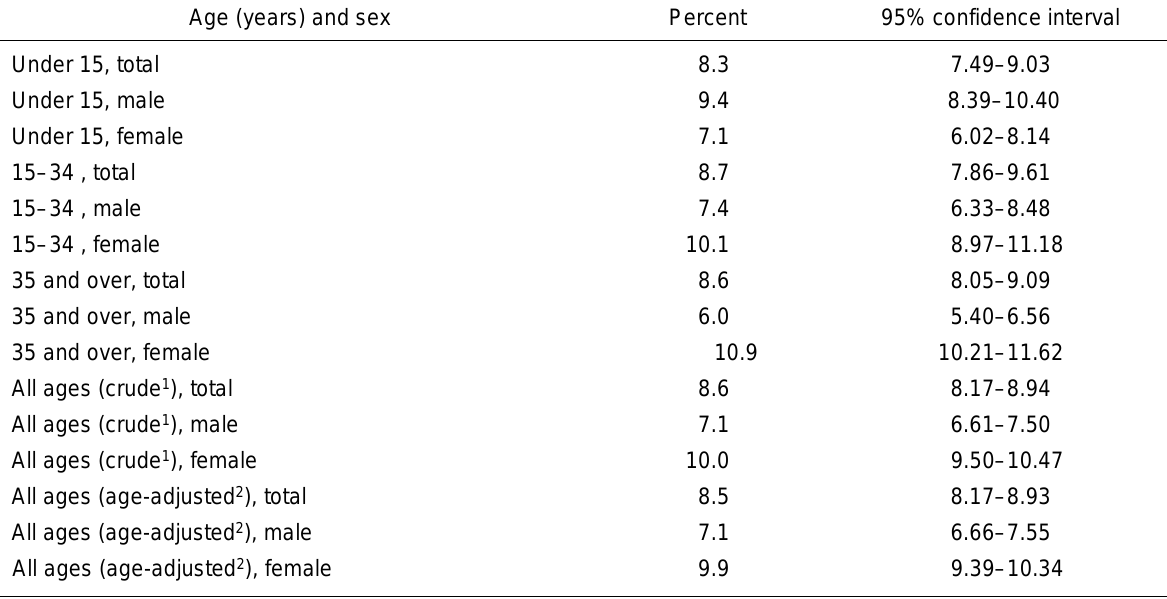
Data table for Figure 15.5. Prevalence of current asthma among persons of all ages, by age group and sex: United States,